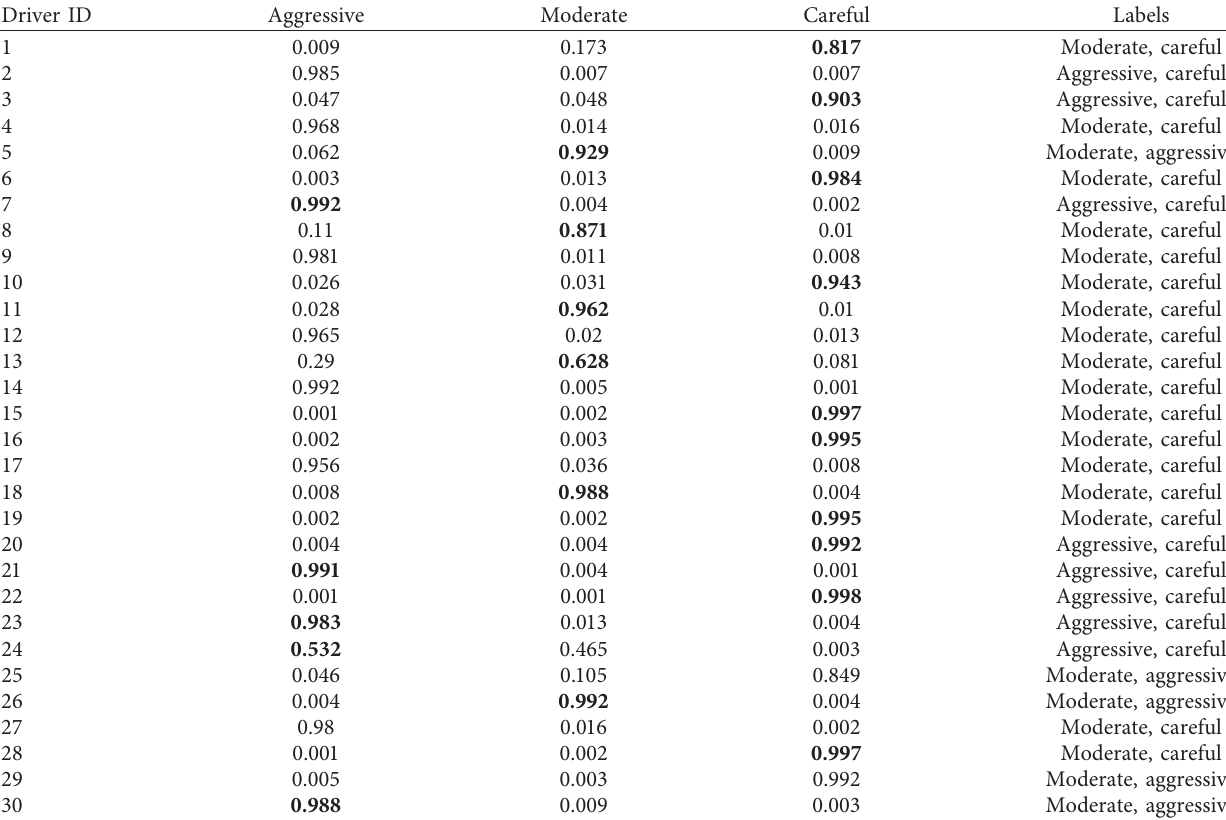
Table 7: Results of the proportions of driving styles for individualization driving in dataset 2. Driver